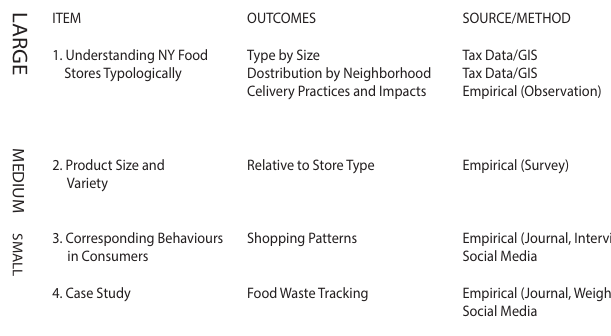
Figure 1. Three scales of